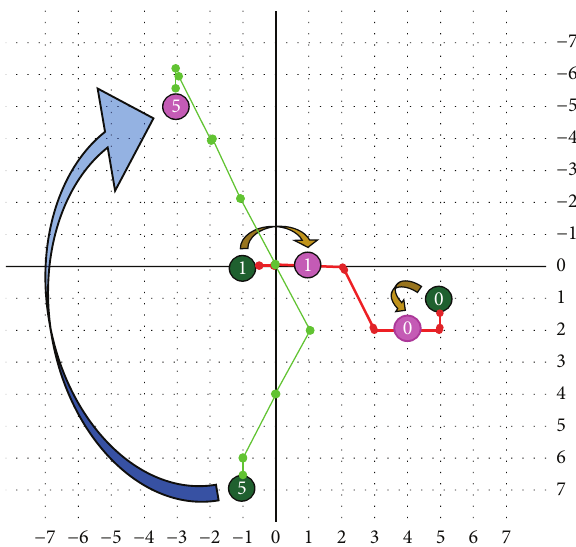
Figure18:Someexamplesofchromosome,crossover,andmutation.